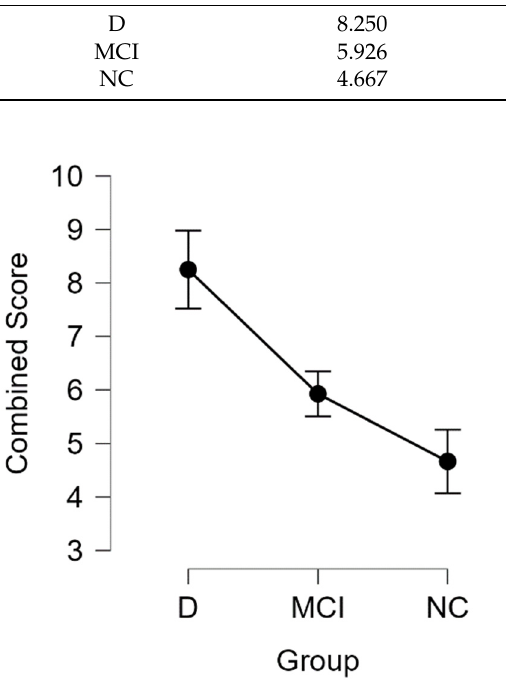
Figure 9. The descriptive plot of combined score in D, MCI, and NC groups with mean value and SD.